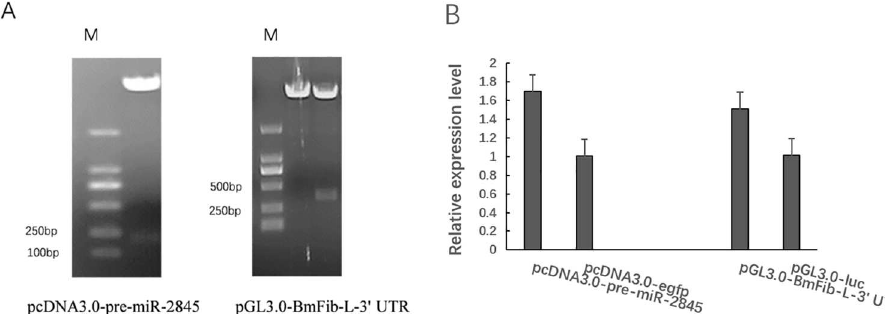
Fig 3. Construction of pre-miR-2845 and BmFib-L 3’UTR expression vectors. A. Dentification of pcDNA3.0-pre- miR-2845 and pGL3.0- BmFib-L- 3’UTR by double enzyme digestion. B. Overexpression verification of pre-miR-2845 and BmFib-L